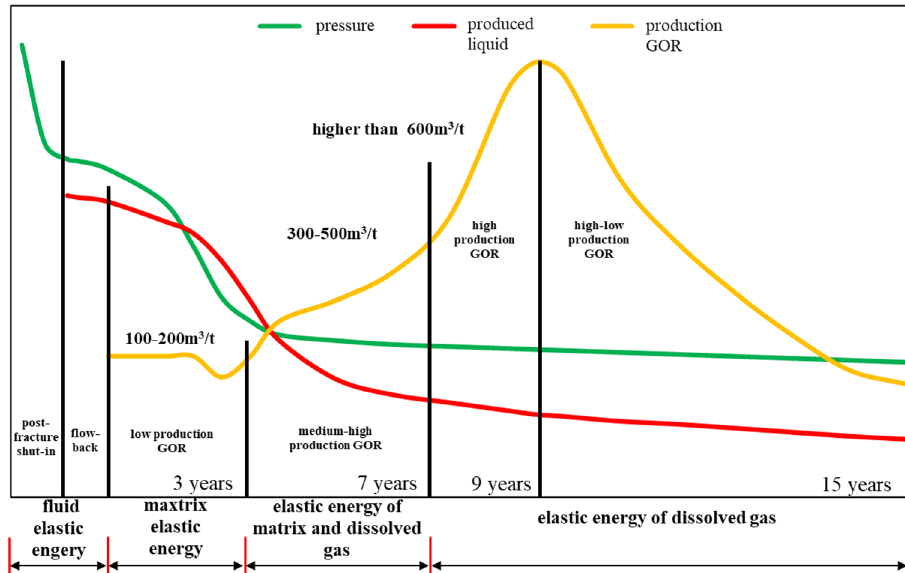
Figure 8. Division of quasi-natural energy development stages of shale oil horizontal wells with large-scale volume